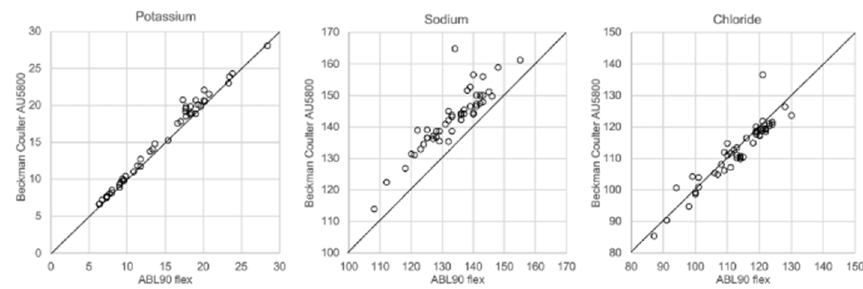
Figure 2. Comparison of ABL90 flex and Beckman Coulter AU5800.